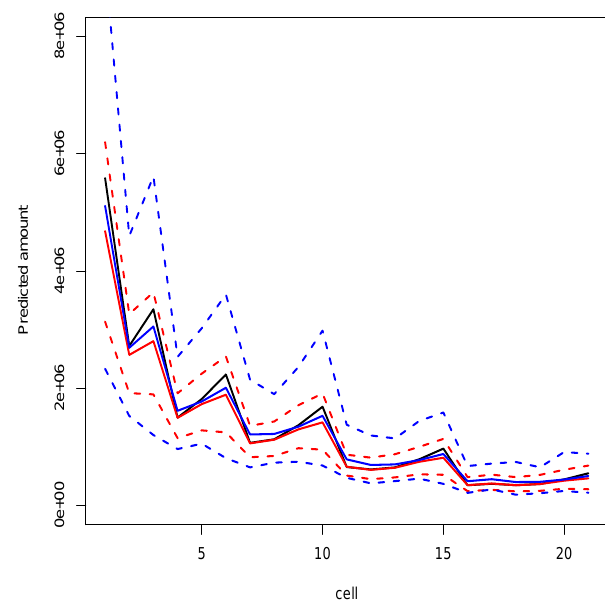
Figure 4. Predictions with the quasi-Poisson macro-level model ( strong black line), with conditional predictions ( red lines) and unconditional ones ( blue lines) from Model G with θ =